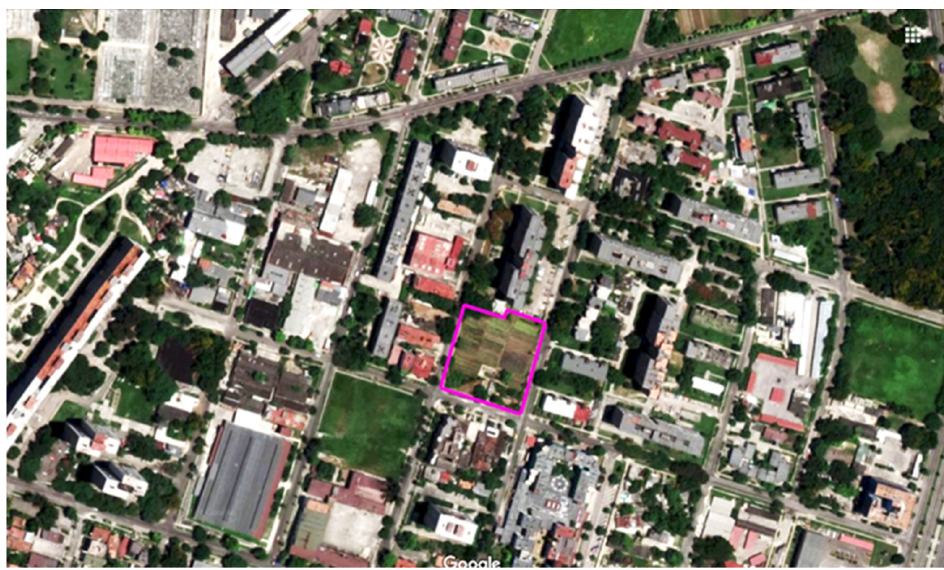
Figure 5. Location of the Organopónico La Sazon farm in Havana (Cuba), (1994) (based on www.google.pl/maps, accessed on 16 August 2018). google.pl/maps, accessed on 16 August